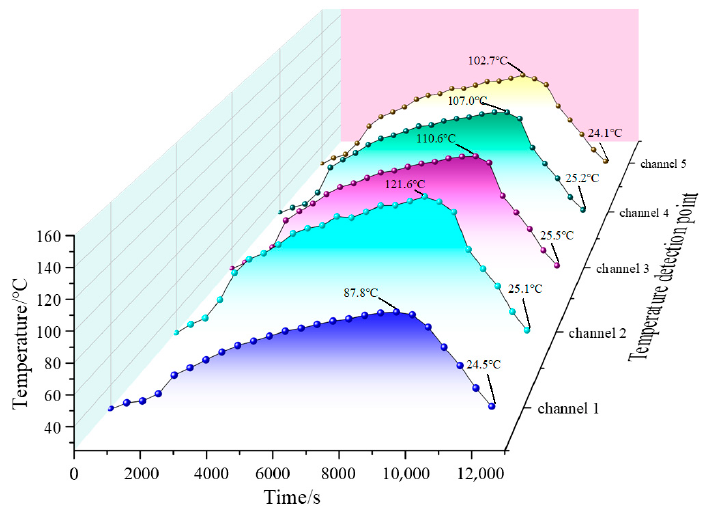
Figure 7. Arrester temperature test under impulse current.